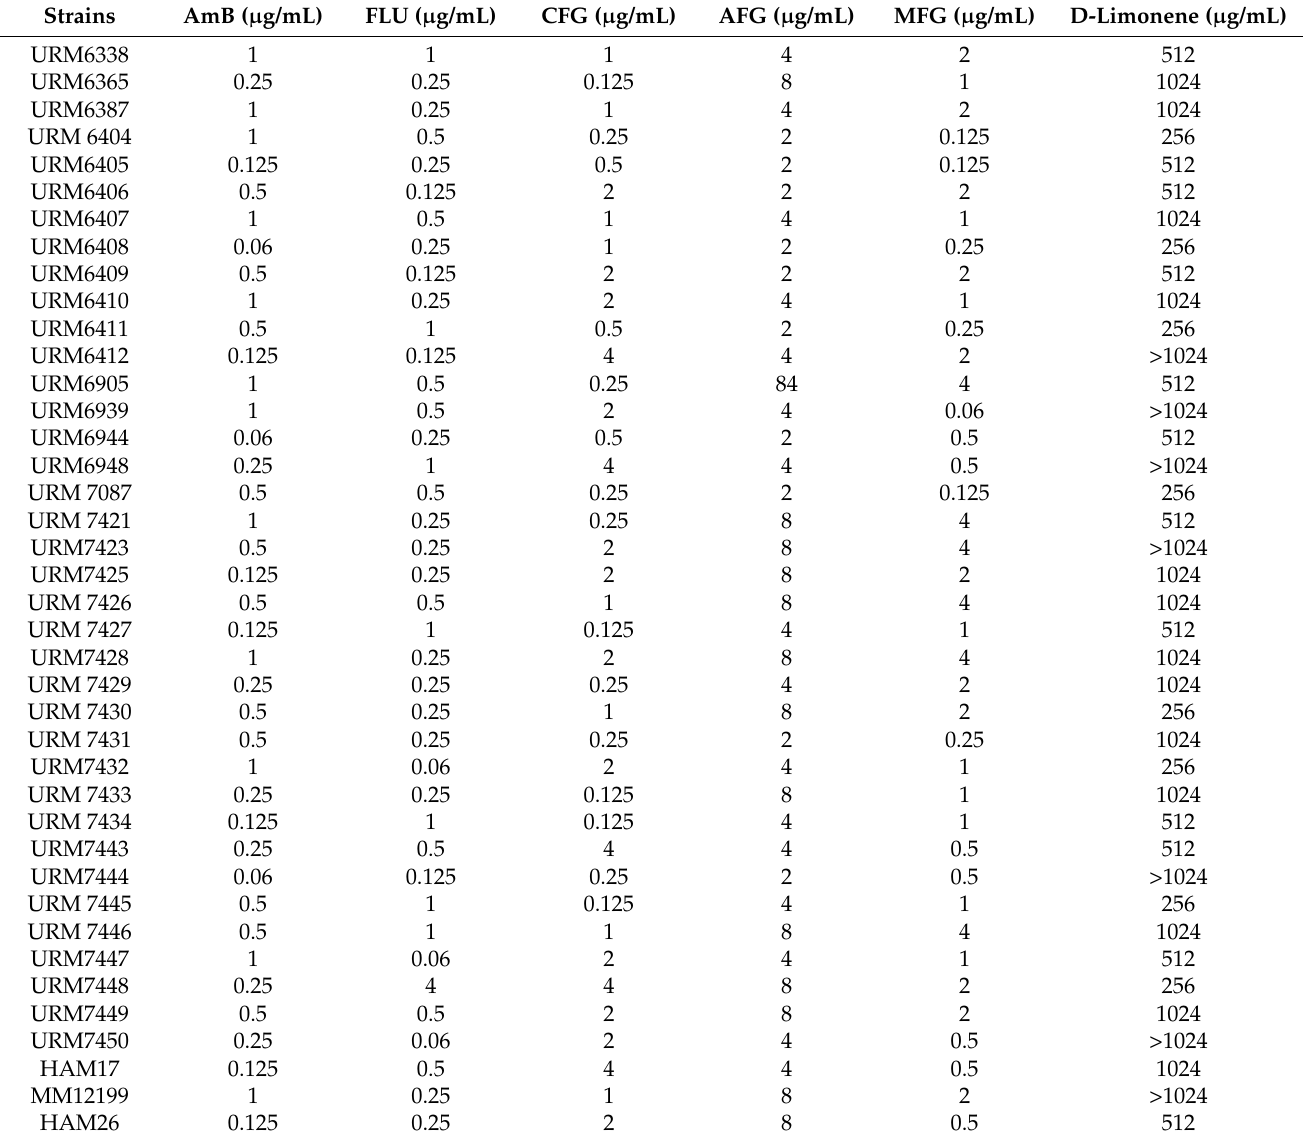
Table 1. Antifungal susceptibility profile of Candida parapsilosis complex strains against commercial antifungals and